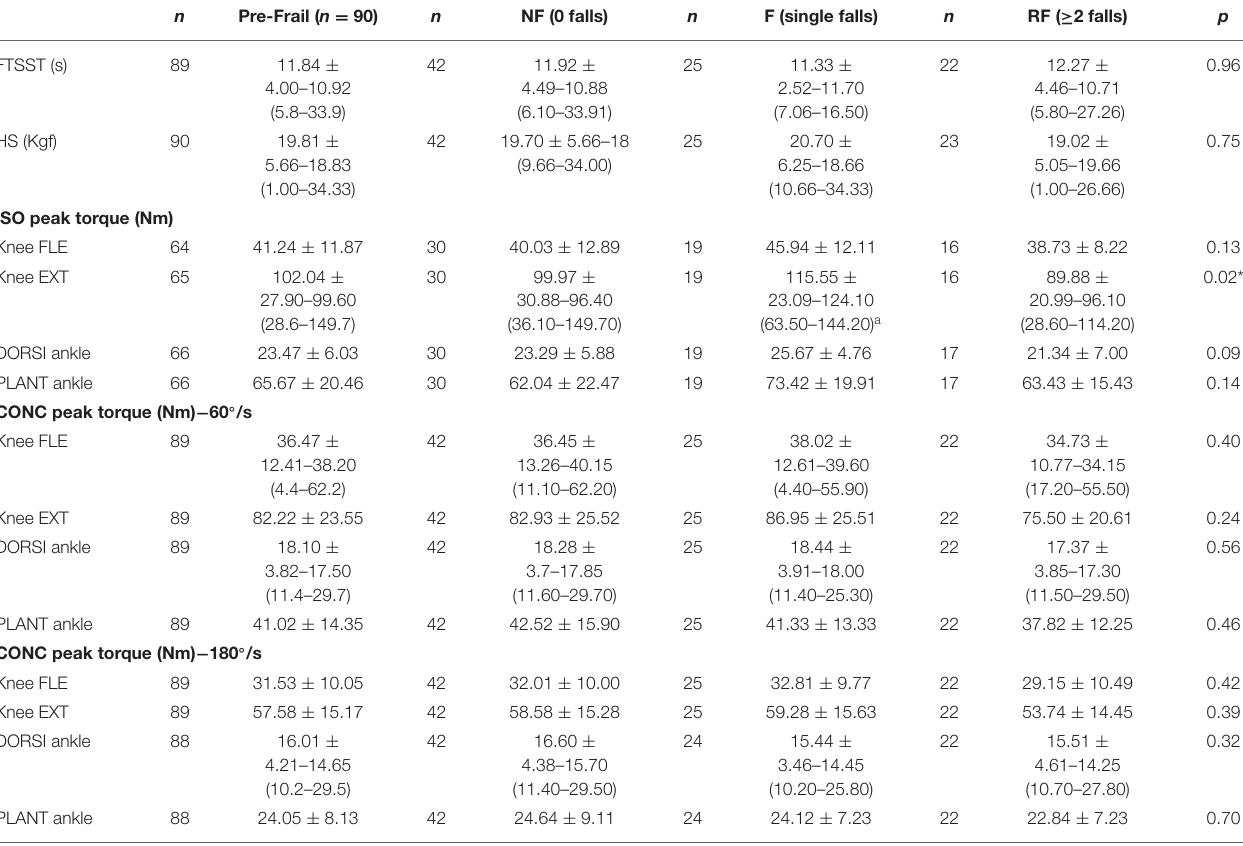
TABLE 3 | Characterization and comparison of muscle force/torque in non-fallers, fallers, and recurrent fallers pre-frail older women.